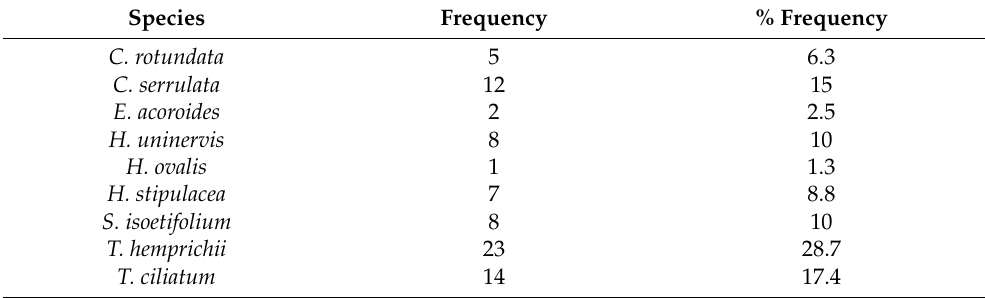
Table 3. Frequency of occurrence of seagrass species within plots in the subtidal area of Gazi Bay.